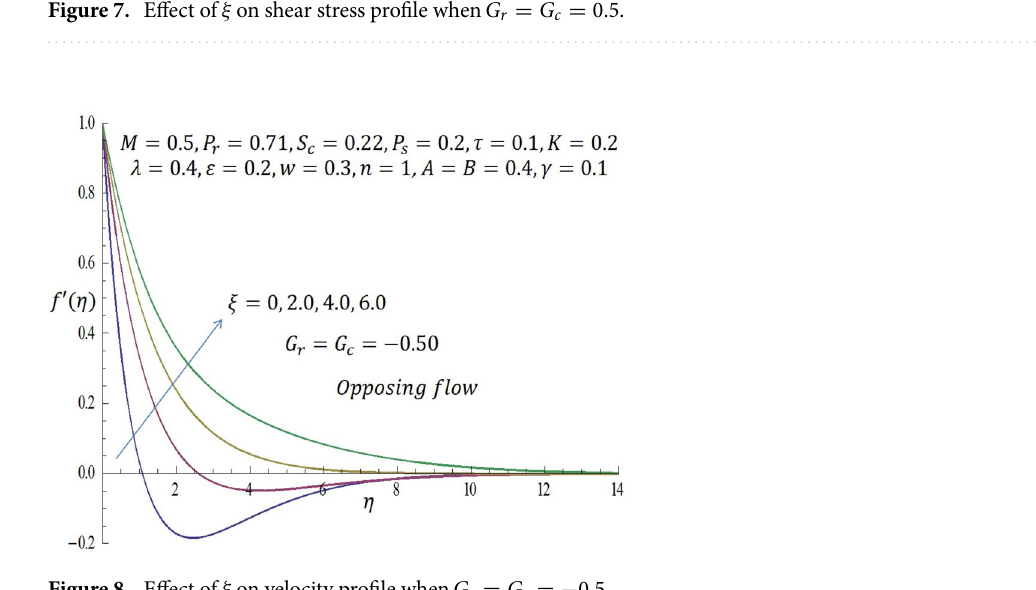
Figure 8. Effect of ξ on velocity profile when G r = G c = − 0.5 .